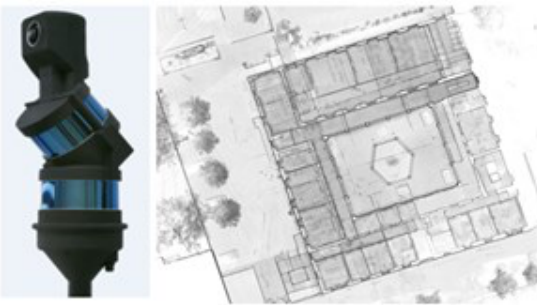
Figure 1. The HERON capture head and the X Ray picture of the zero level of the building The surveying phase has been carried out in one hour walk along the various school areas, providing, as first result, a colorized 3D point cloud model (with 2 cm resolution and accuracy) and the surveyor trajectory connected with the panoramic high resolution images. As deliverables, various products have been extracted from the model and produced to the experts. Plants and elevations have been provided in the form of a X ray scaled image, importable in the most common CAD platforms or measurable using a free software tool provided with HERON. The X Ray picture is a 2,5D orthophoto extracted starting point to extract the BIM model of the site. The